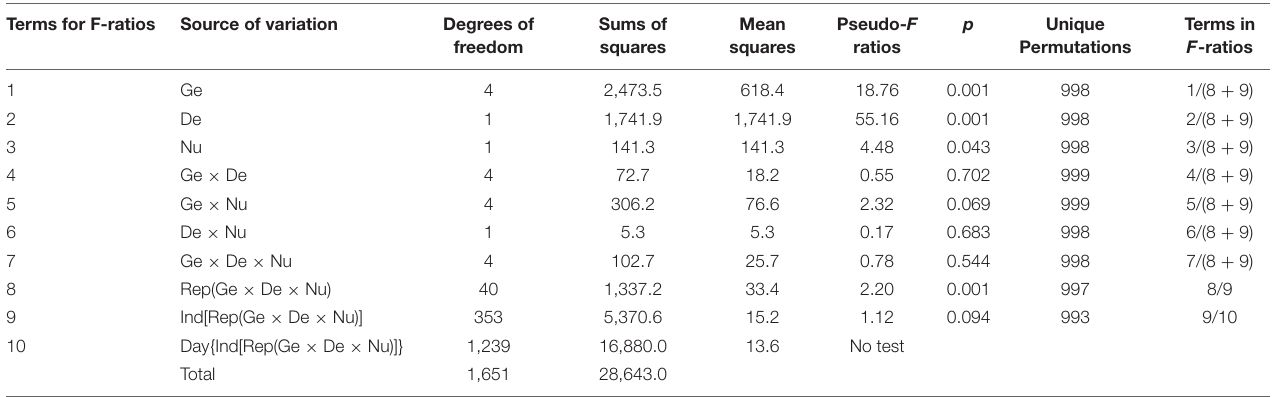
TABLE 1 | Results of permutation analysis of variance for incremental growth rates. Terms for F-ratios Source of variation Degrees of